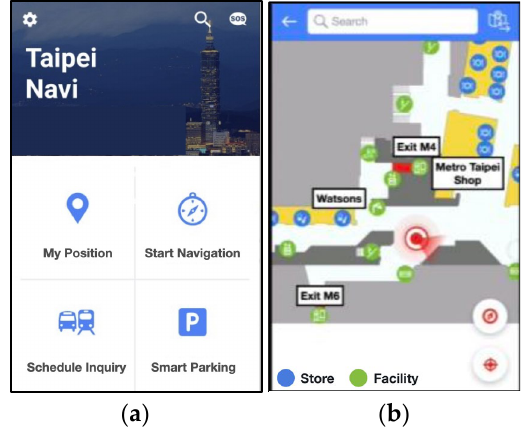
Figure 5. ( a ) Taipei Navi app home screen; ( b ) Taipei Navi app navigation screen.